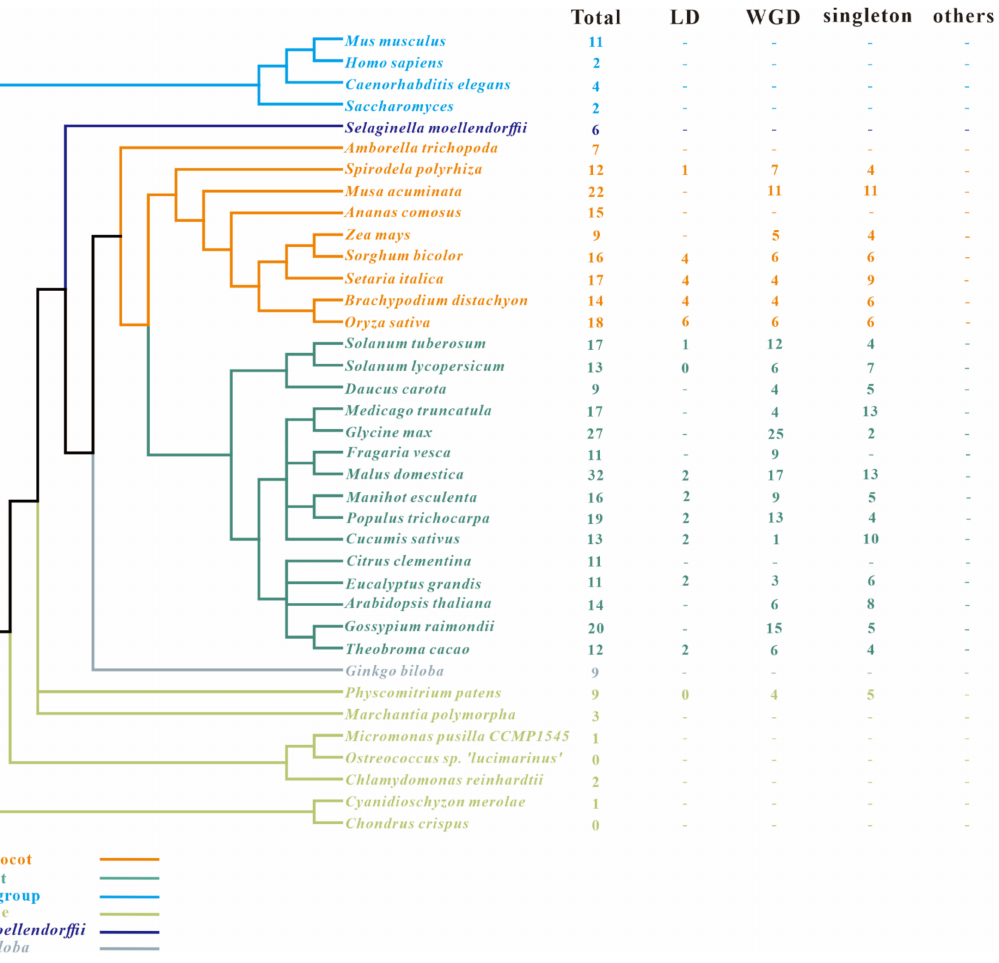
Figure 2. Taxonomic tree of surveyed species. Total number of genome-widely identified SAPs in each species and the numbers of SAPs involved in different duplication-modes are also listed. Species from different taxonomy and/or species are marked with different colors. “Total” represents total SAP gene numbers in each species. “LD” represents local duplication, including tandem and proximal duplication; “WGD” represents whole-genome/segmental duplication; “singleton” represents genes without paralogous pairs in MCScanX; “others” represents genes other than LD, WGD, and singleton; “-” means duplication mode was not